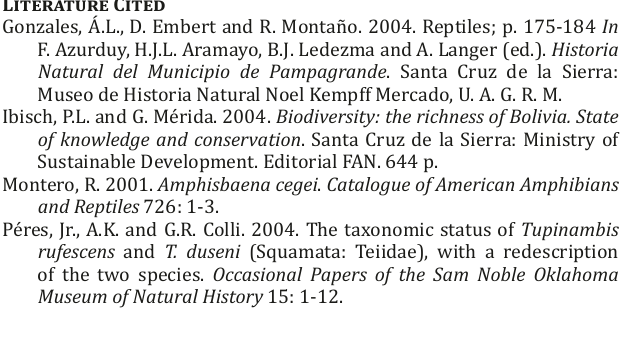
from near Remates, Province of Caballero, Department of Santa Cruz,